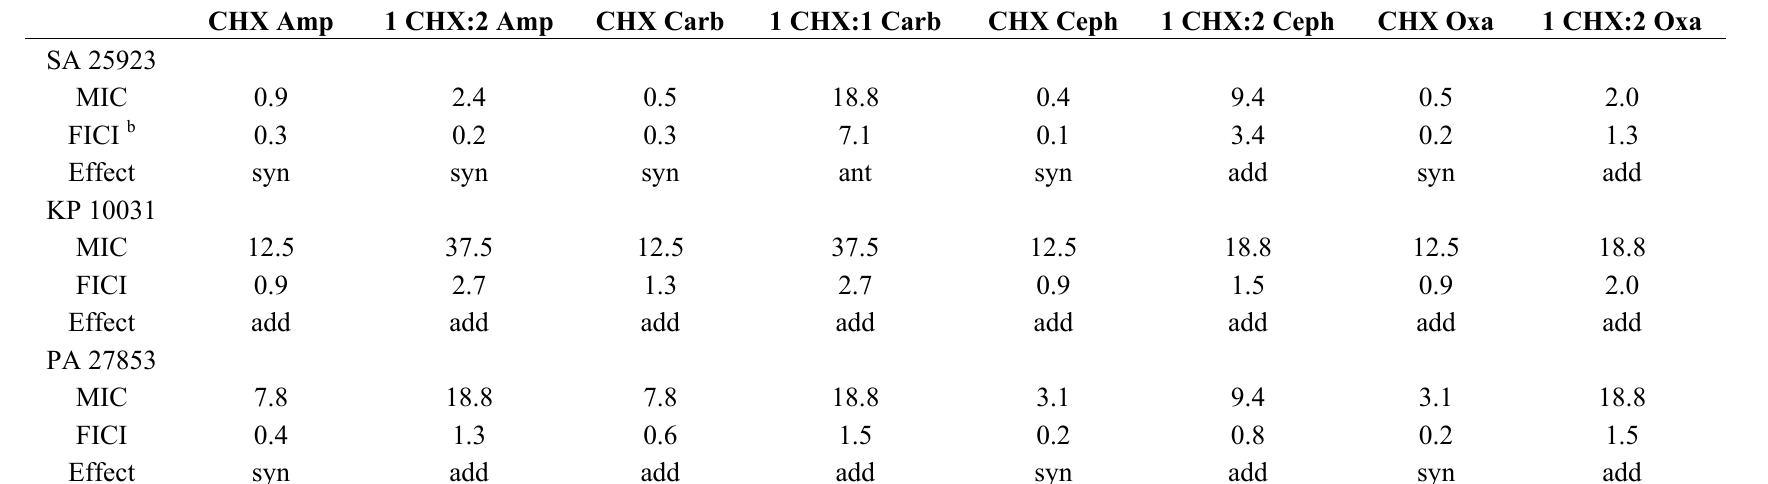
Table 5. MICs (μM) and FICI of four GUMBOS and their unreacted mixtures at stoichiometric equivalence against three quality control strains a . CHX Amp CHX